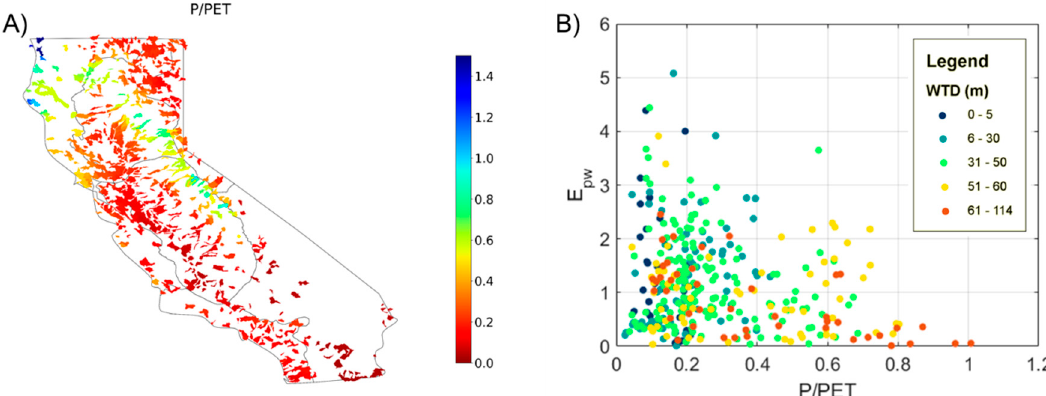
Figure 11. Humidity index of order-1/order-2 catchments ( A ), the elasticity of FrcSA to winter precipitation in relation with humidity index and groundwater table depth (WTD) ( B ).